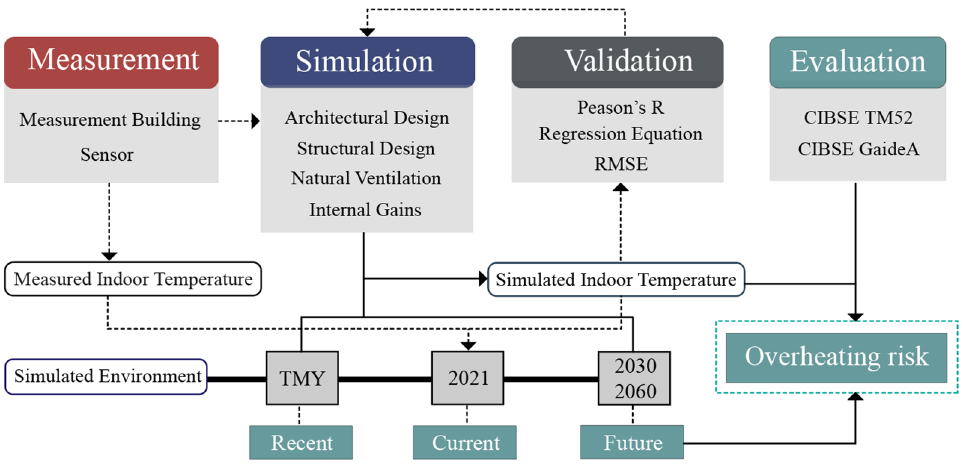
Figure 2. Framework of the study.